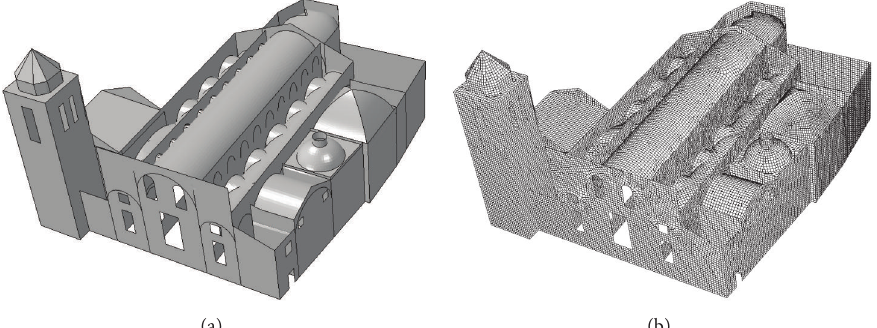
Figure 5: Linear dynamic analysis: 3D FE model of the church (a) geometry of the masonry mid-plane and (b) mesh of the 3D shell elements model. Roof structure is hidden to